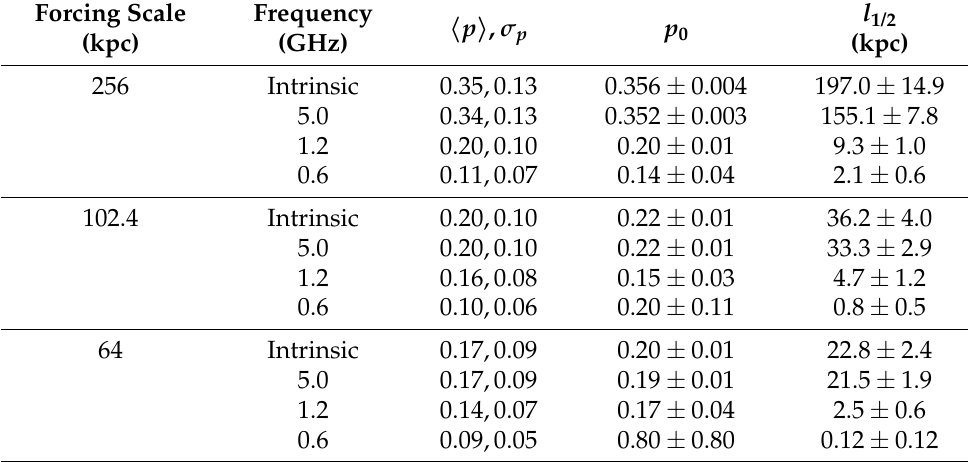
p Table 4. Values of and σ p obtained from the synthetic maps at 5, 1.2 and 0.6GHz for the three (cid:104) (cid:105) forcing scales l f = 256,102.4 and 64kpc. The ‘intrinsic’ values refers to the frequency-independent values, equivalent at λ = 0, obtained by turning off the effects of Faraday rotation. p 0 and l 1/2 are the p best-fit values obtained by fitting the variation of with smoothing scale modelled by Equation (2). (cid:104) (cid:105) Forcing